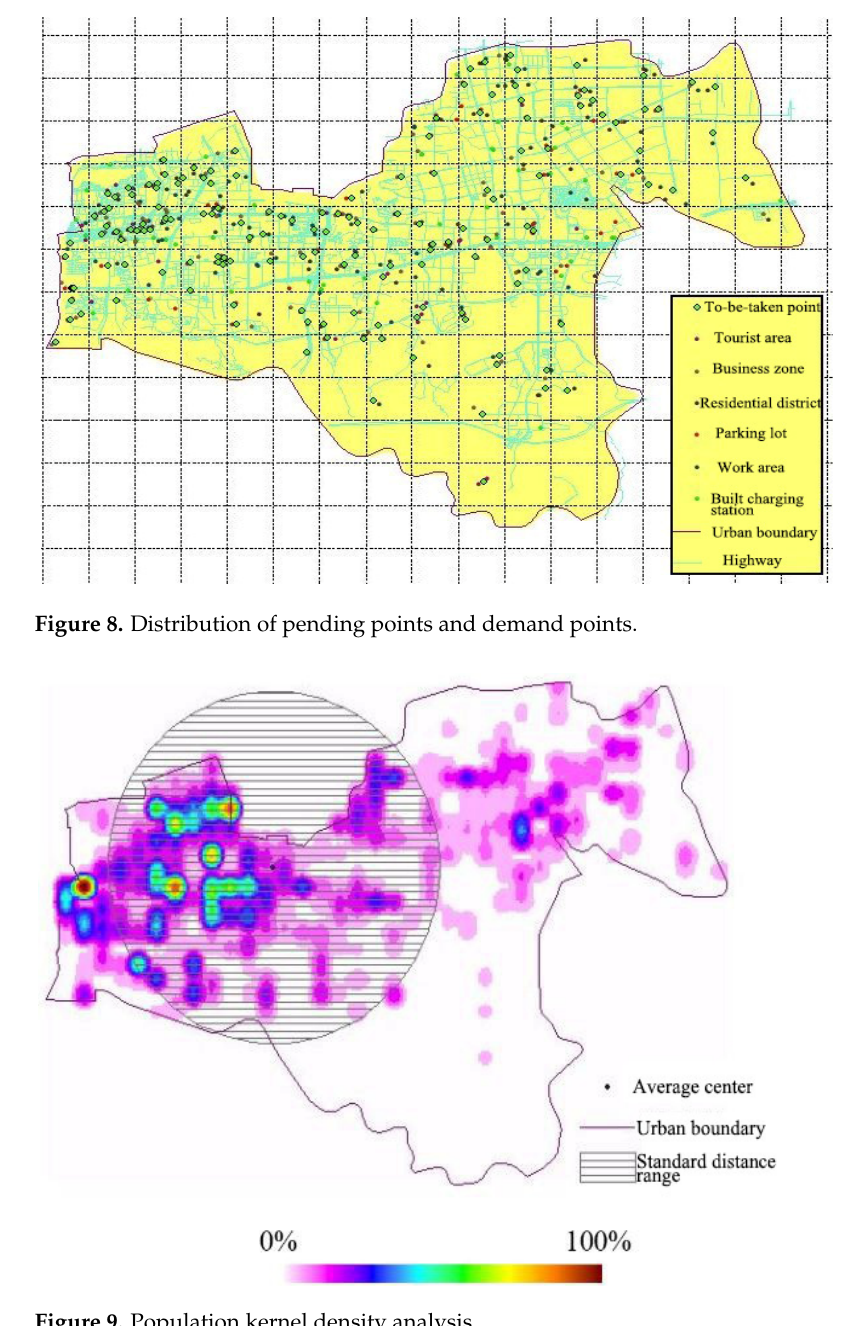
Figure 9. Population kernel density analysis. Table 2. Sensitivity analysis of the number of electric vehicle charging stations constructed. Number of Sites